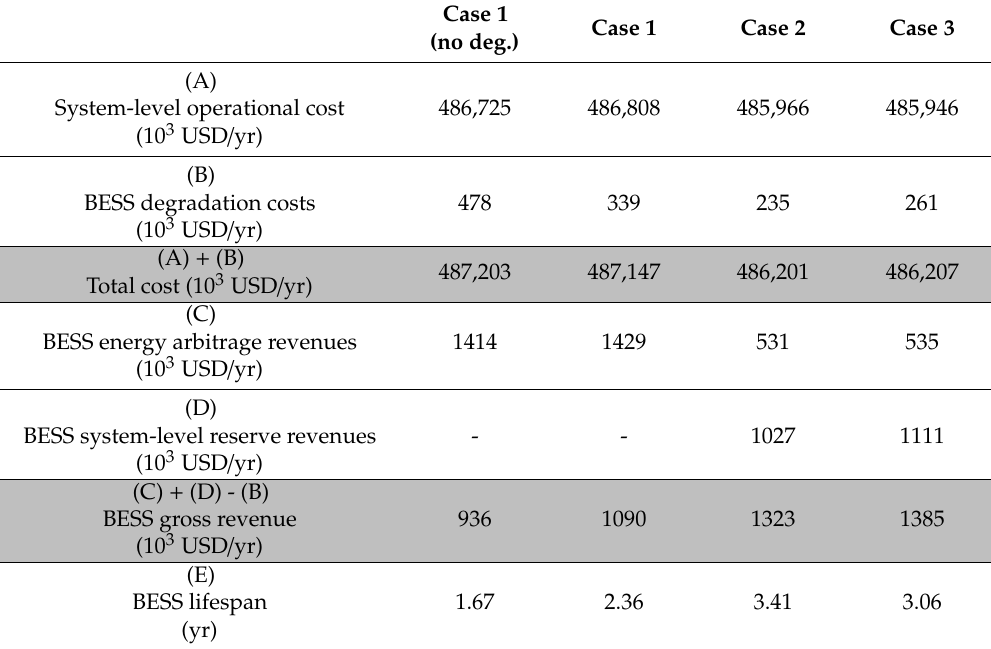
Table 3. Costs, revenues and battery energy storage systems (BESS) lifespan